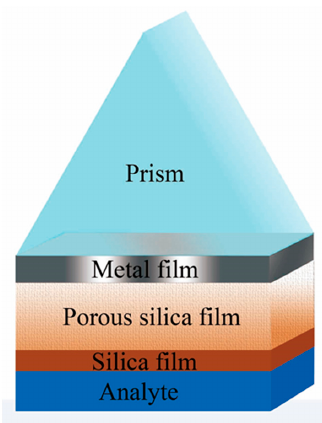
Figure 1. Schematic of the surface plasmon resonance (SPR) sensor with a porous silica film.